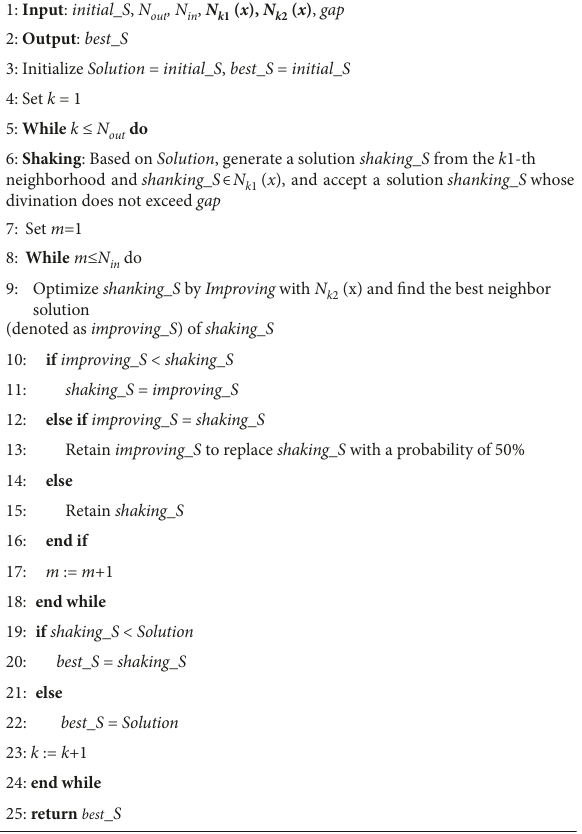
Figure 5: The VNS algorithm.